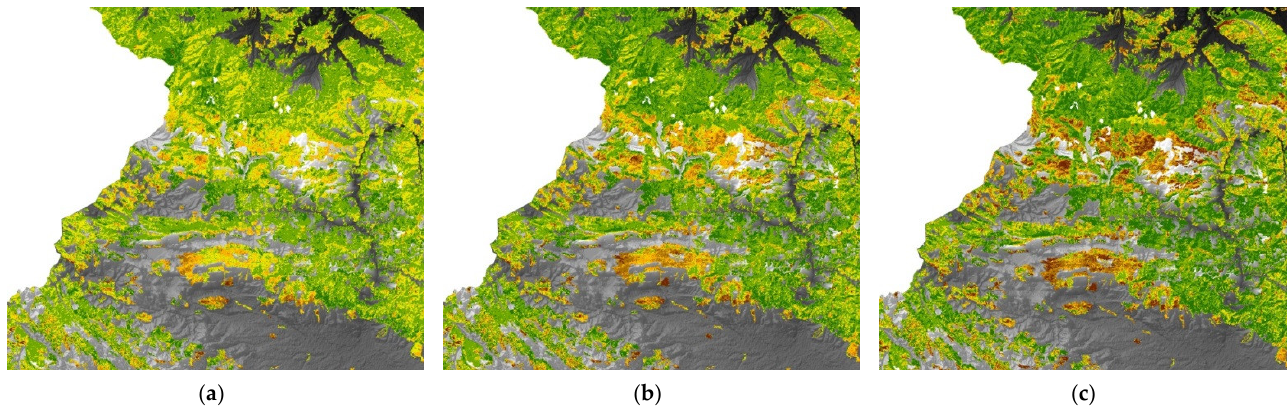
Figure 14. Distribution of Drought coefficient (DC) in the western Balkan range in the middle of August ( a ), at the beginning of September ( b ), and in the middle of September ( c ); scale 1:400,000 .